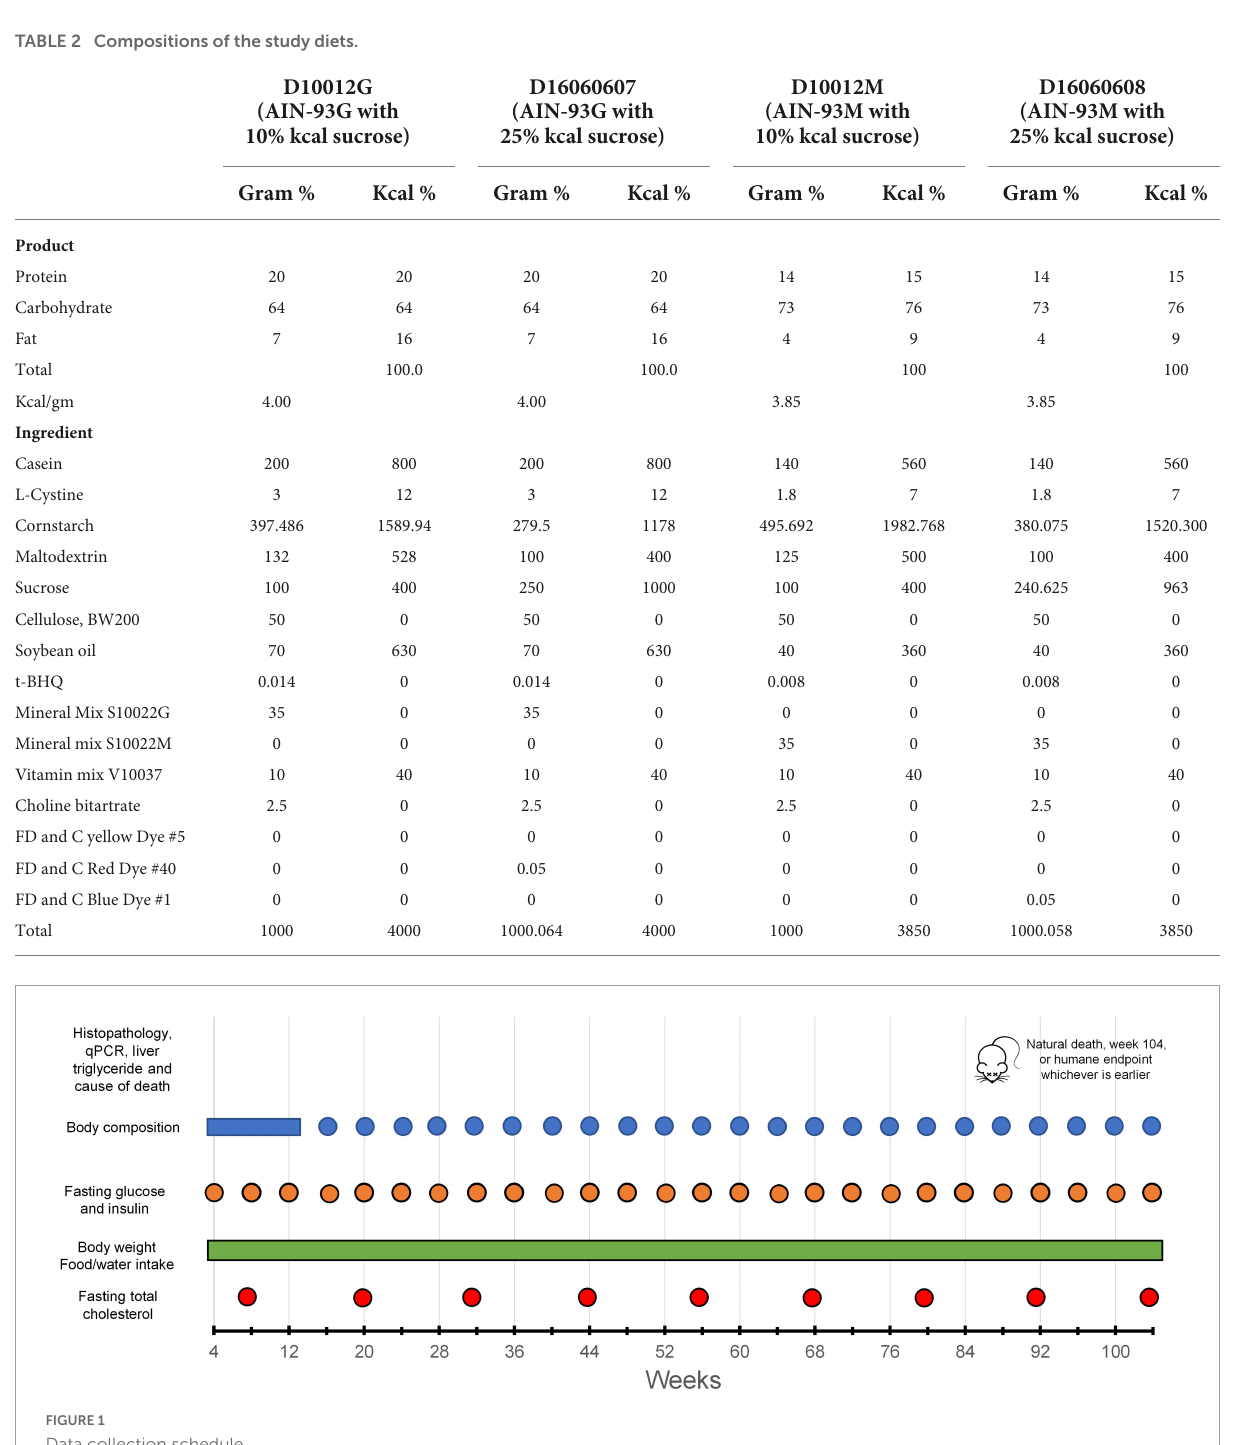
FIGURE1 Data collection